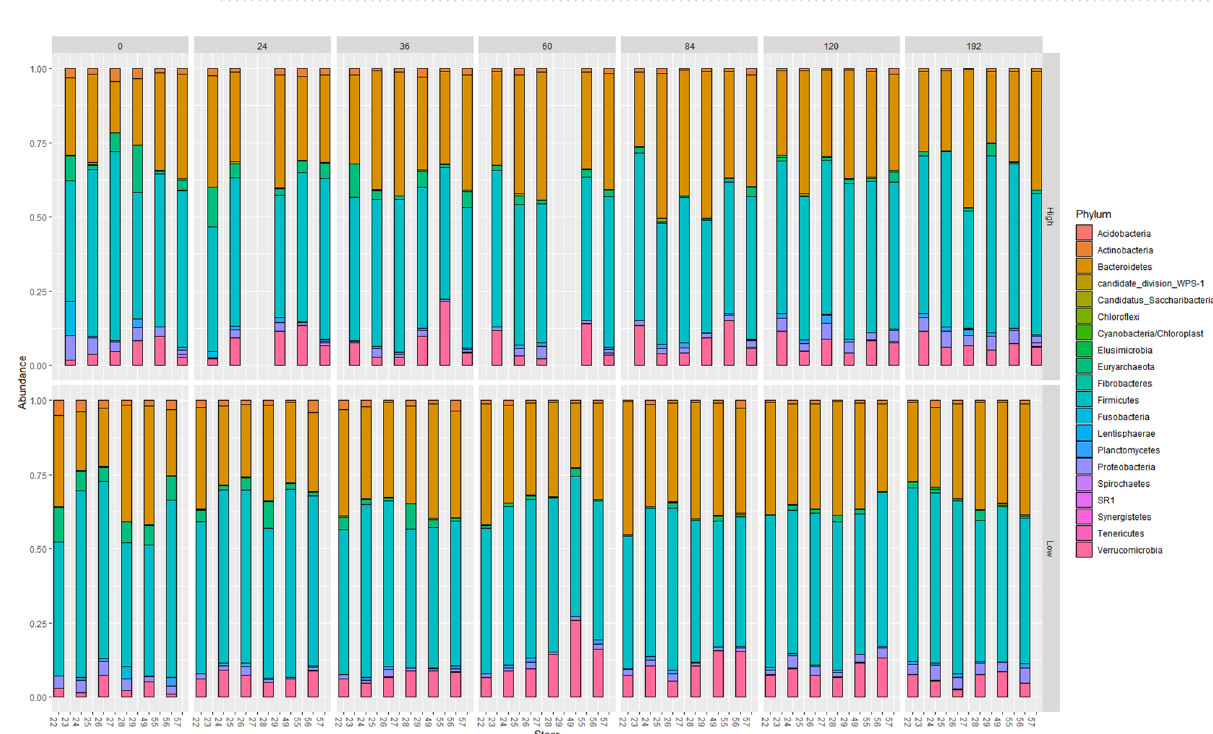
Figure 9. Relative abundance plotting of Phylum over time per dosing group. A relative abundance plot demonstrating the change in microbial composition (at the Phylum level) over time for each individual steer per high and low dose